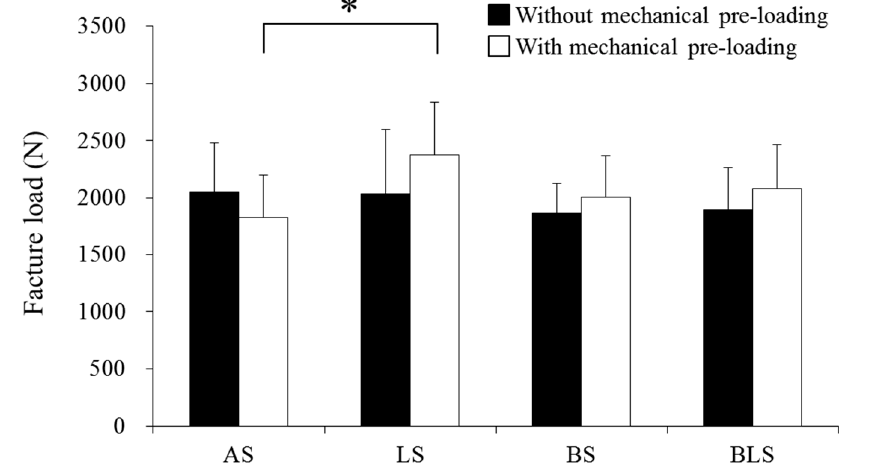
lowercase letters in the same row indicate that the groups are significantly different ( p < 0.05). Details of experimental groups are shown in Table 1.